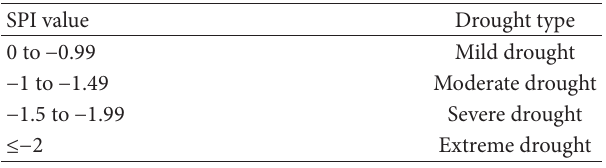
Table 1: Drought category based on the SPEI value. SPI value Drought type 0 to −0.99